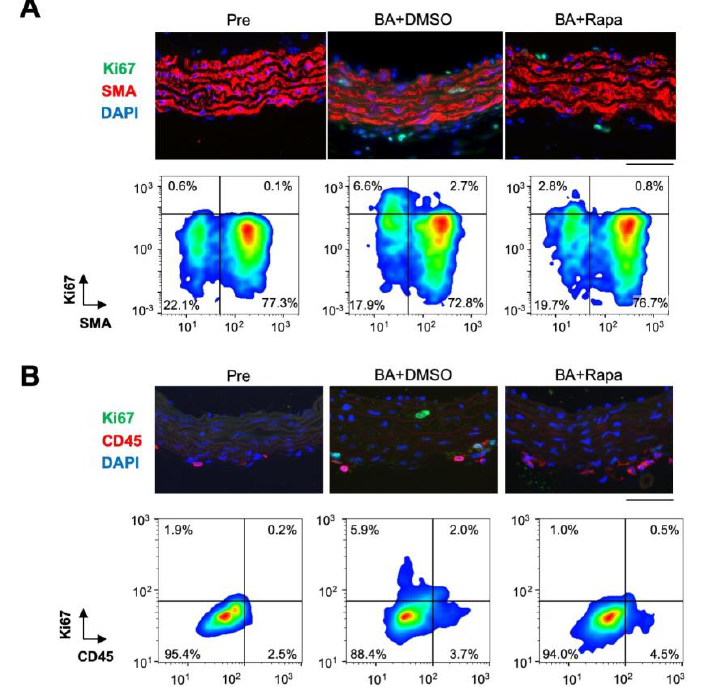
Figure 2. Effect of rapamycin in aortic tissue. Immunofluorescence staining of the aortic tissue for Ki67 and SMA ( A ) or CD45 ( B ) with nuclear 4’,6-diamidino-2-phenylindole (DAPI) staining, before (Pre) or after 3 days of BAPN + AngII challenge with vehicle (BA+DMSO) or rapamycin (BA+Rapa) treatment. Representative immunofluorescence images (upper panels) and scattergrams of imaging cytometry (bottom panels) are shown. The percentages of cell populations are indicated in the scattergrams of the quadrants as arbitrarily determined by the thresholds for the signal intensities of Ki67 ( A , B ), SMA ( A ) and CD45 ( B ). The thresholds are set constant for Pre, BA+DMSO, and BA+Rapa in a given double staining. Scale bars: 50 µm.